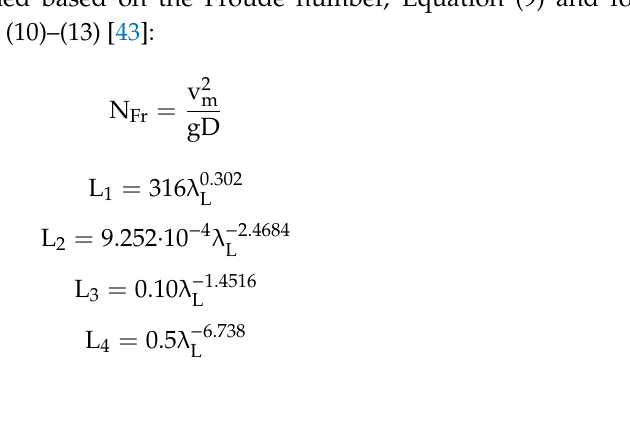
Table 2. Values of coe ffi cients of local dissipation of mechanic energy used for